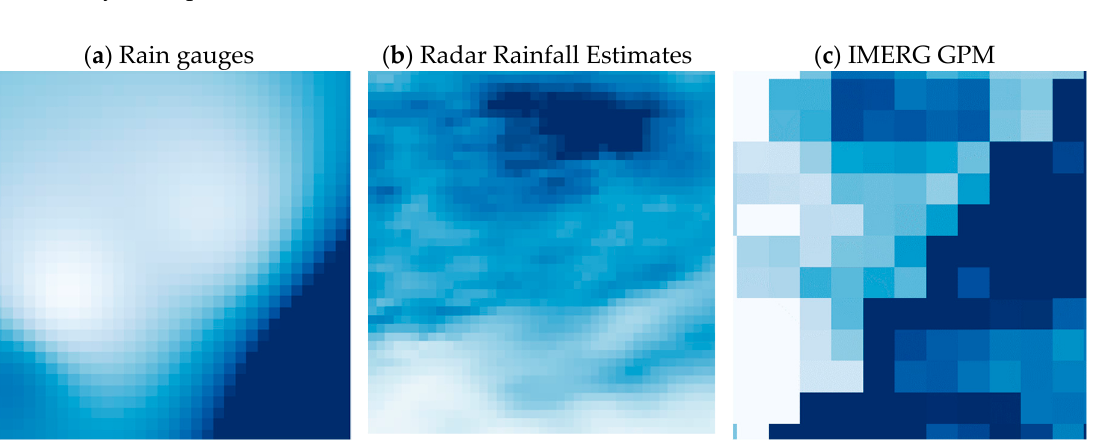
Figure 4. Comparison of gridded precipitation data: ( a ) Rain gauges—interpolated point data (1 × 1 km); ( b ) Radar—radar rainfall estimates (1 × 1 km); and ( c ) IMERG GPM—satellite precipitation (11 × 11 km).